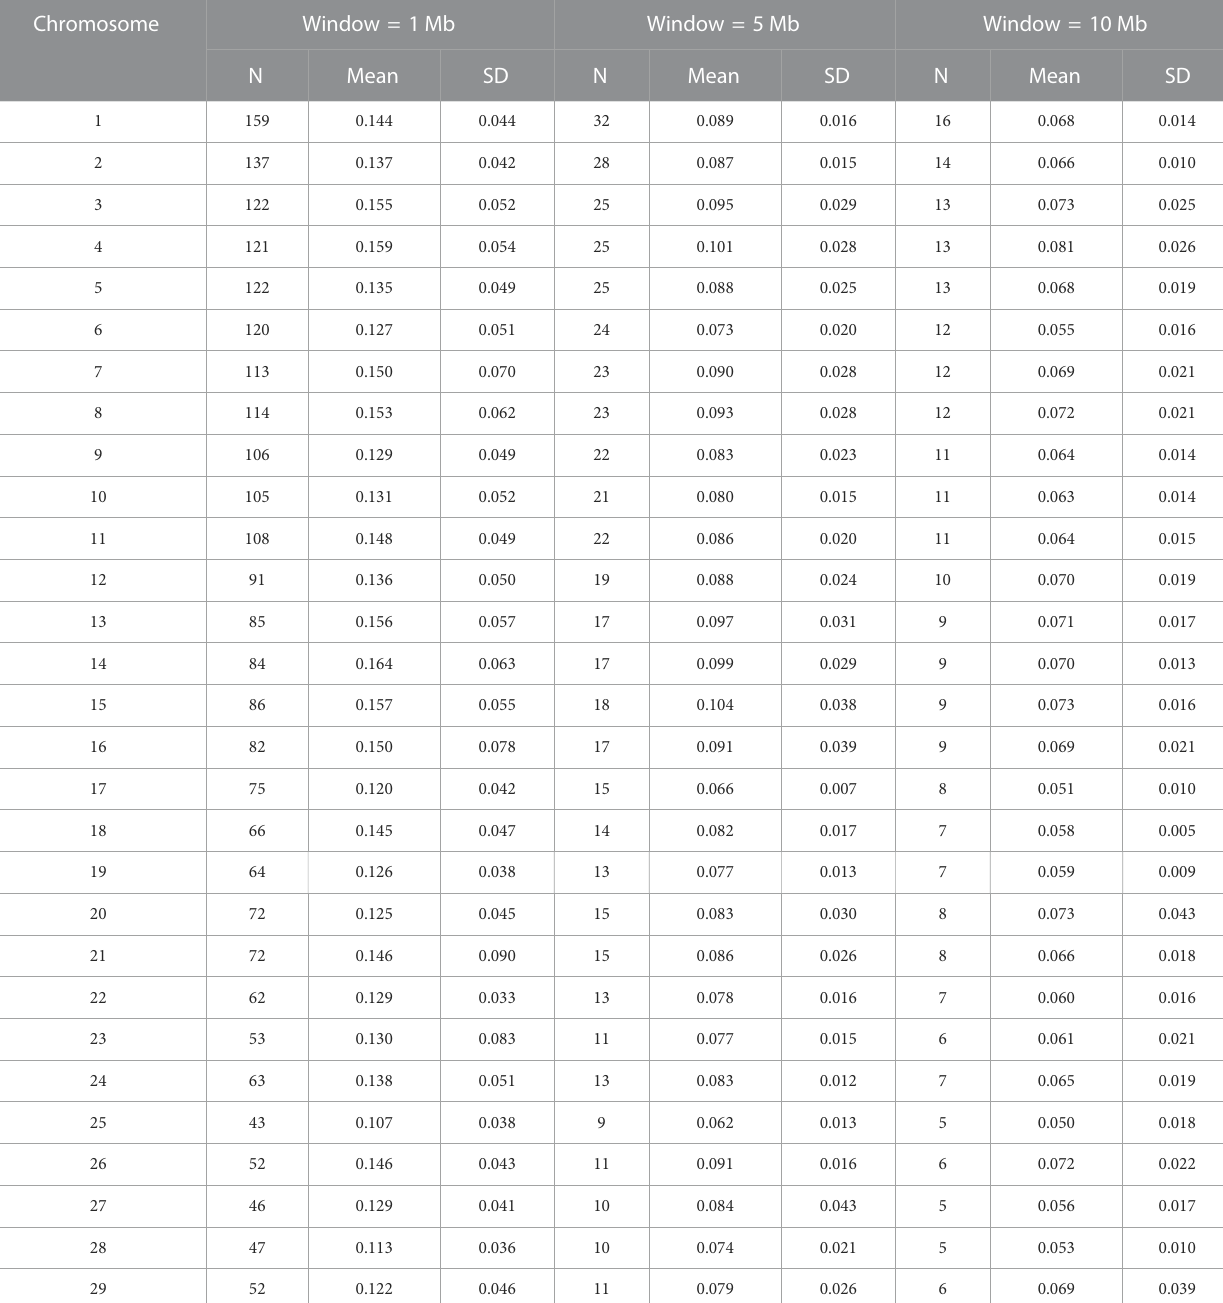
TABLE 2 Mean and standard deviation (SD) of R 2 linkage disequilibrium (LD) among SNPs evaluated by varying window sizes (1 Mb, 5 Mb, and 10 Mb) on each chromosome a .